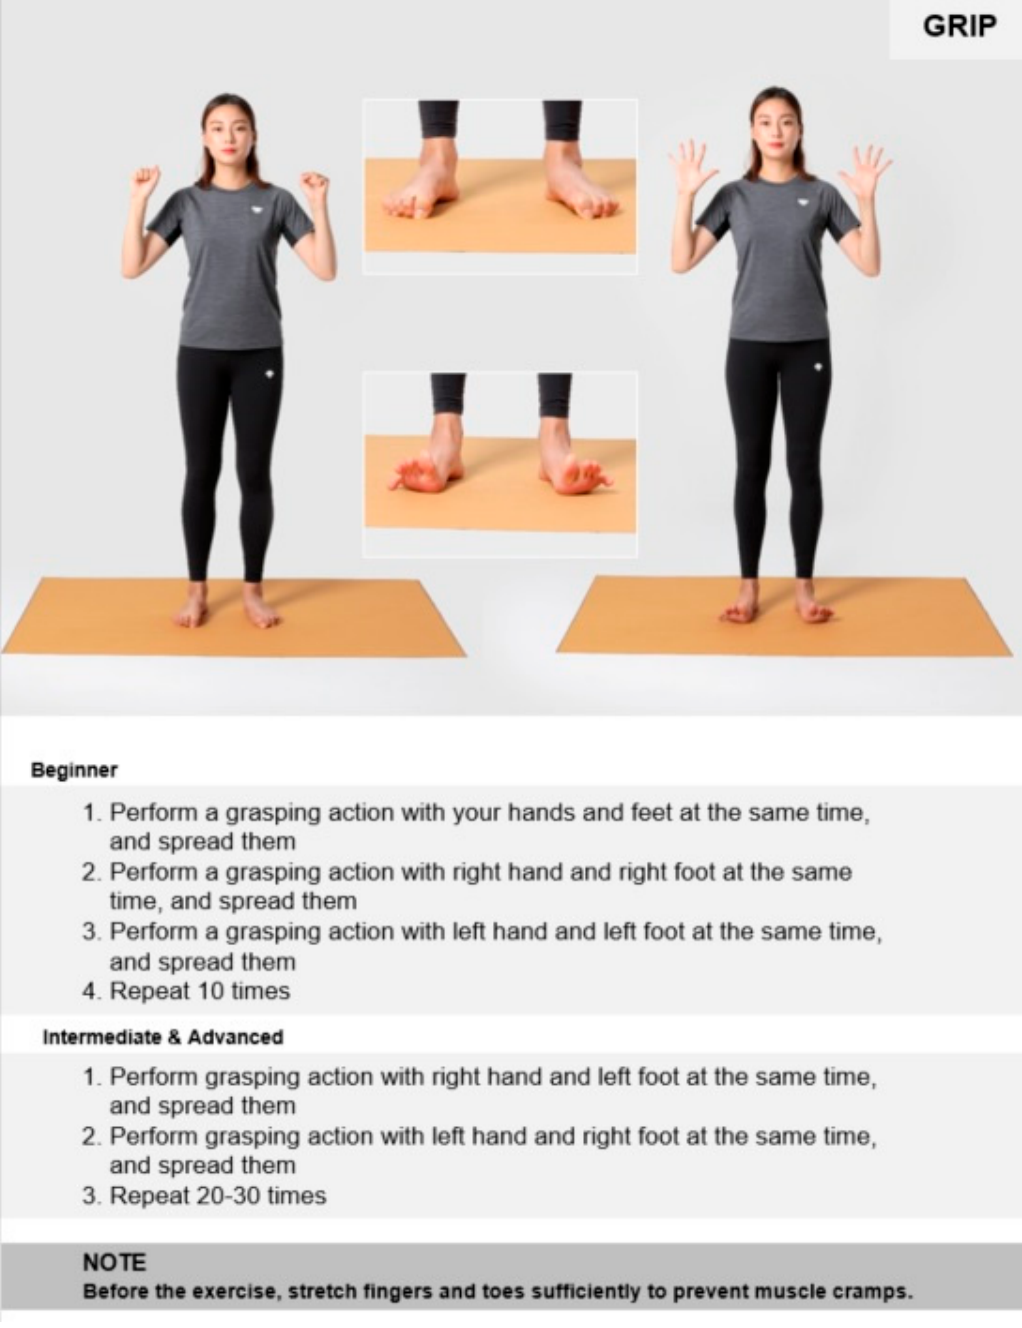
Figure A23. Detailed description and components of each movement in the “Grip” finger-and-toe exercise.